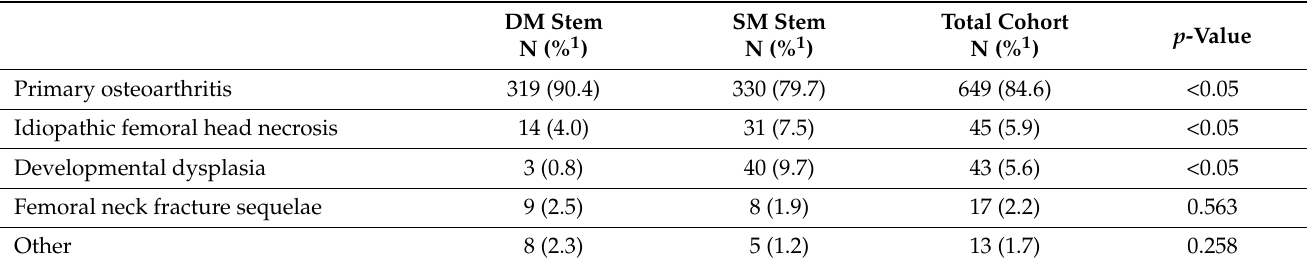
Table 2. Indication for total hip arthroplasty.